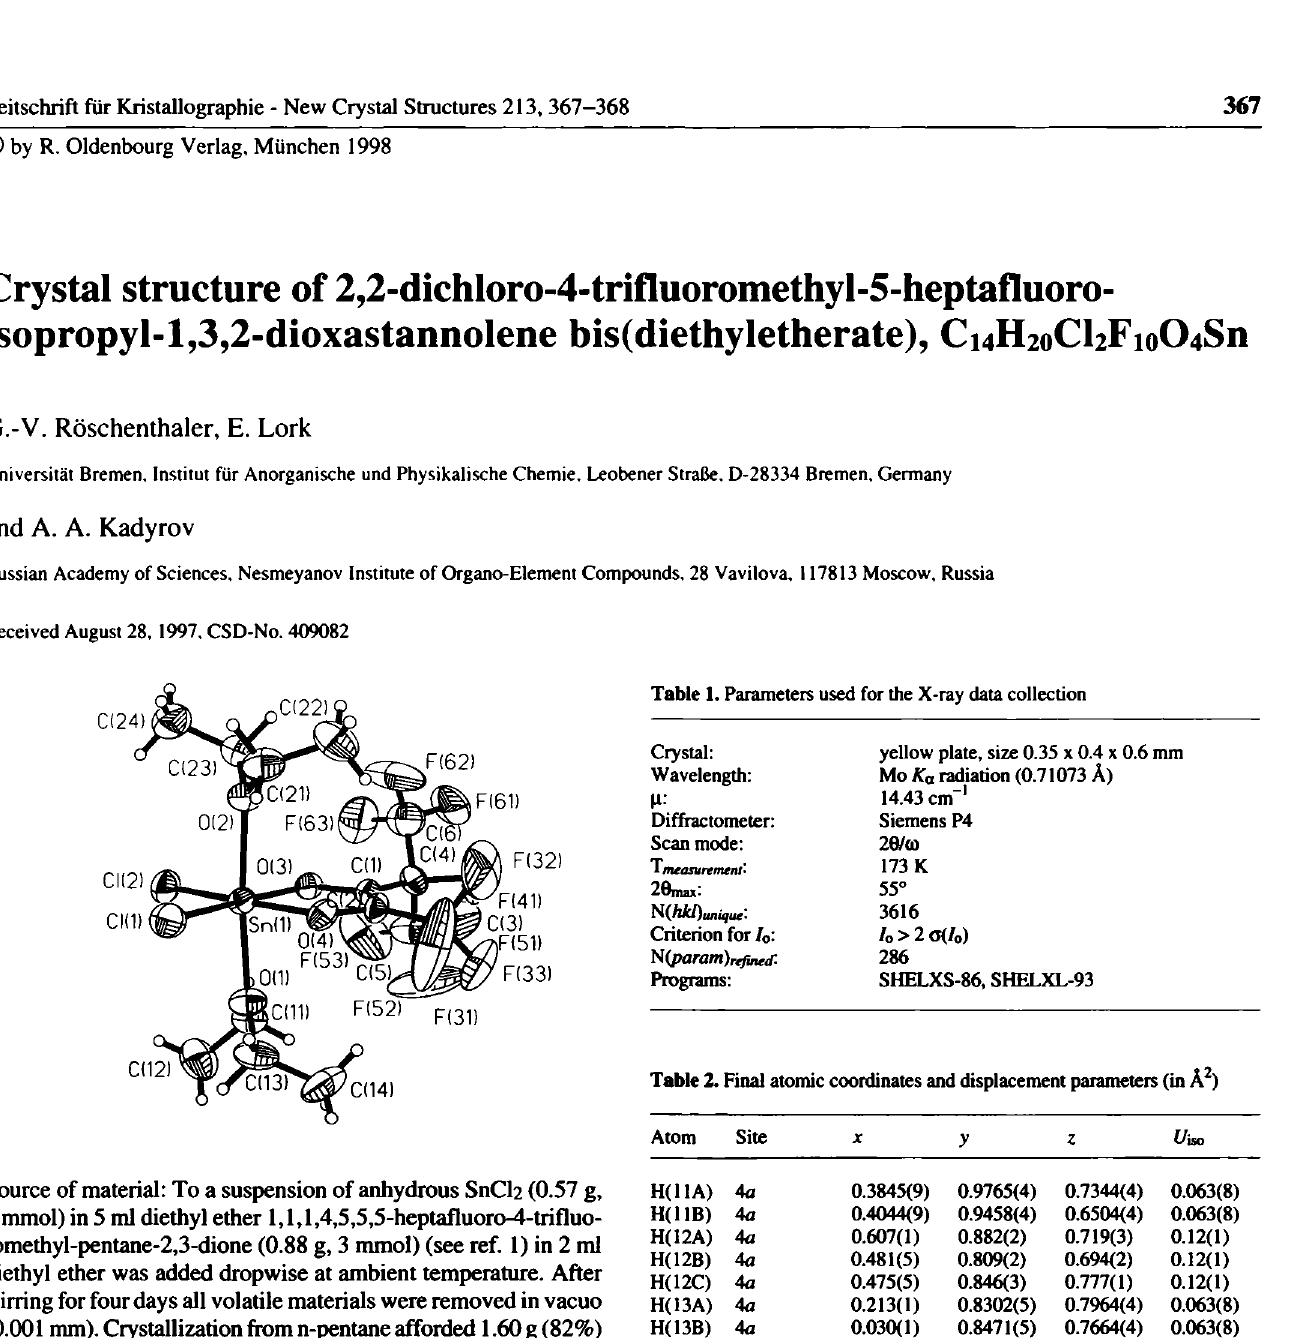
Table 2. Final atomic coordinates and displacement parameters (in